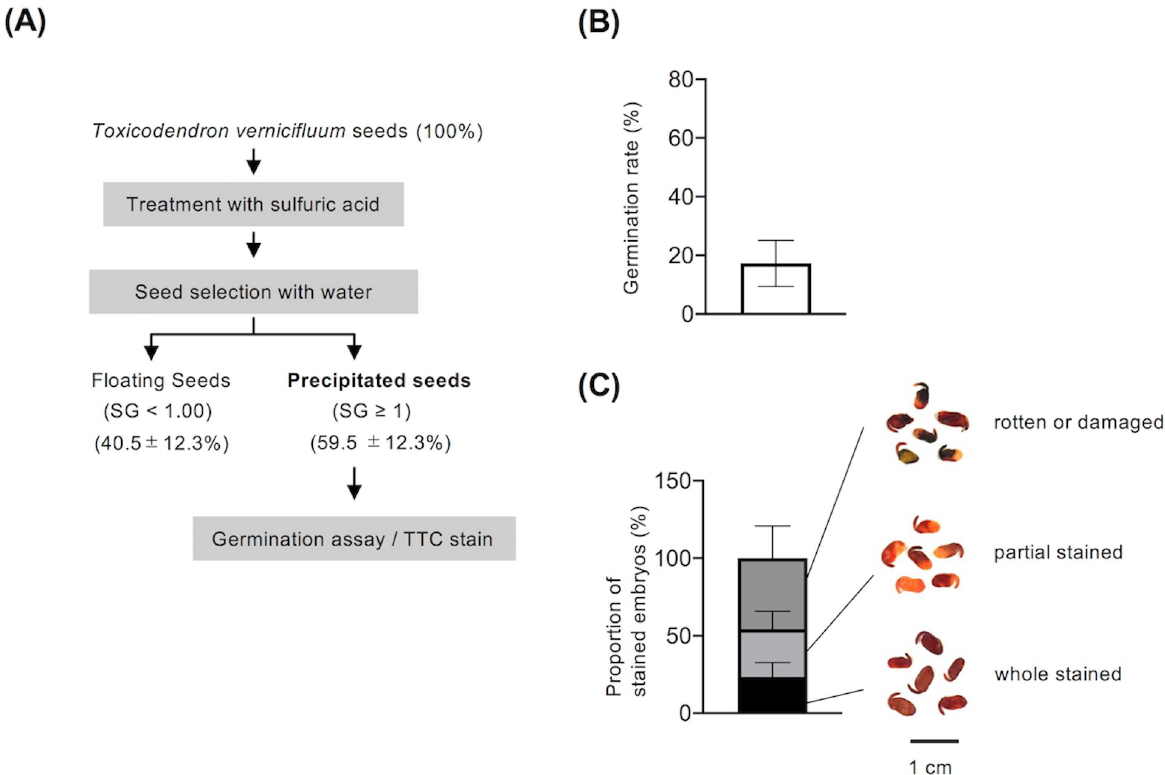
Fig 3. Germination characteristics and viability of seeds selected by conventional methods. (A) Schematic of seed selection by conventional methods. Seeds were separated using sodium chloride solutions of different specific gravities (SGs), and the proportions (%) were calculated based on the initial number of seeds. (B) Germination rate. After cold pretreatment for 3 weeks, seeds were incubated at 20˚C, and germinated seeds were counted 60 days after the start of incubation. (C) Seed viability test. Seeds were cut with a sharp scalpel to collect embryos. The embryos were incubated overnight with TTC solution and photographed (right). The stained embryos are classified into three types: whole-stained embryos, partially stained embryos, and rotten or damaged embryos (right). The total number of embryos investigated was normalized to 100, and the proportion of embryos of each type was calculated (left). Averages and standard deviations are shown for seeds collected in 2018, 2019, and 2020 ( n = 3) (B, C). Scale bar = 1